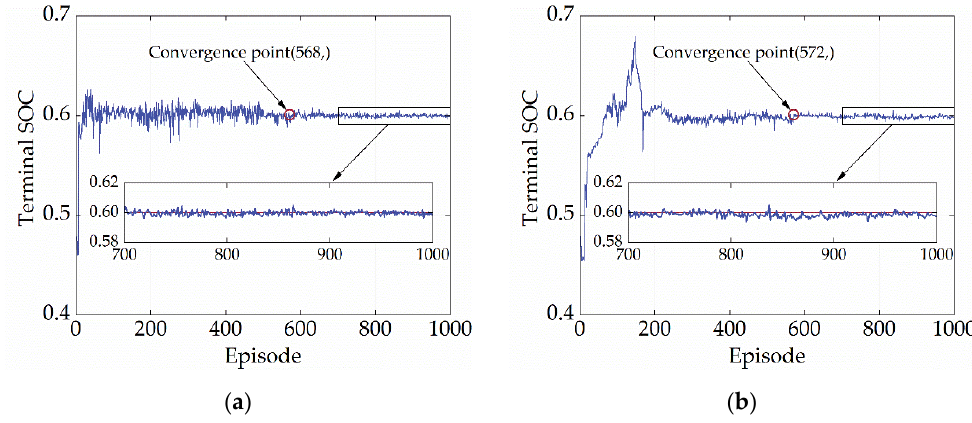
Figure 7. Reward curves under different driving cycles. ( a ) CHTC-B; ( b ) WVUCITY.